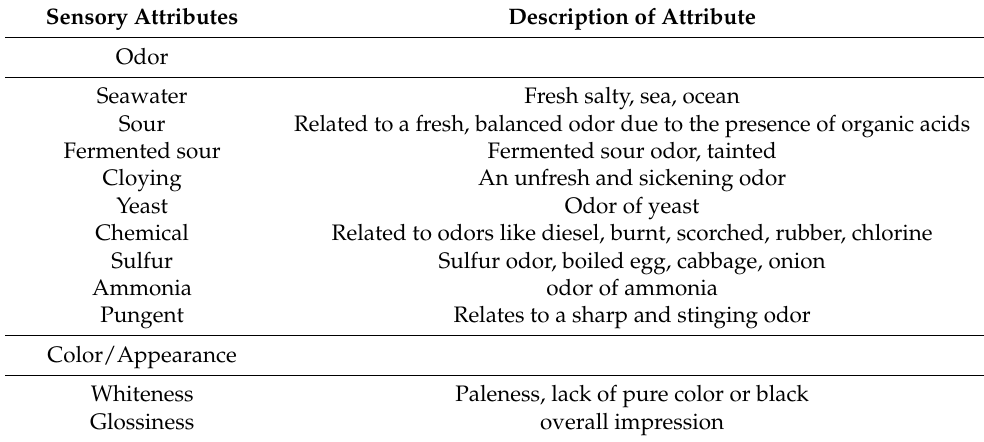
Table A3. Sensory vocabulary for raw samples of cod fillets ( Gadus morhua ) of odor attributes and for